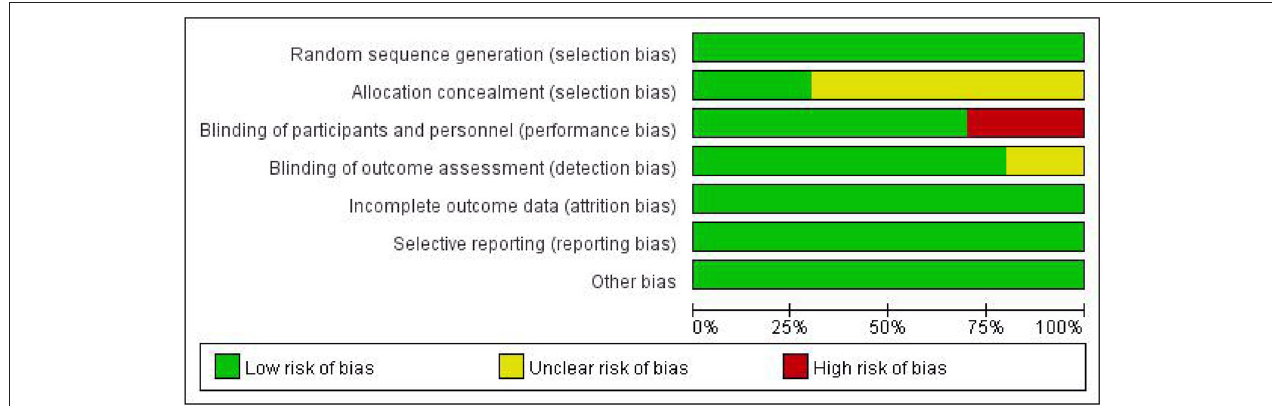
FIGURE 2 | Risk of bias graph.